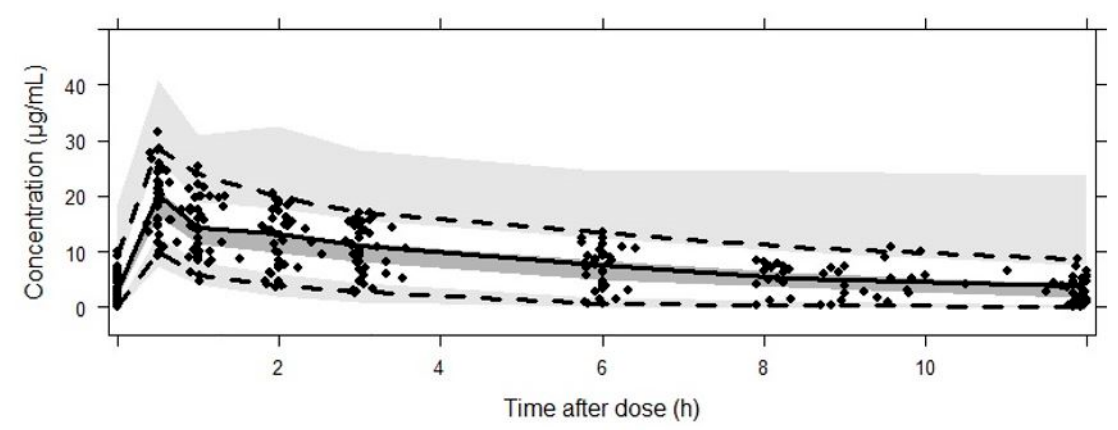
Figure 2. Results from the VPC from 0 to 12 h after dose. Dots correspond to the observed concentrations (µg/mL). The continuous line represents the median, while the dashed lines correspond to the 2.5th and 97.5th observed percentiles. Simulation-based 95% CIs for the median and both 2.5th and 97.5th percentiles are displayed by dark-gray and light-gray shading, respectively.